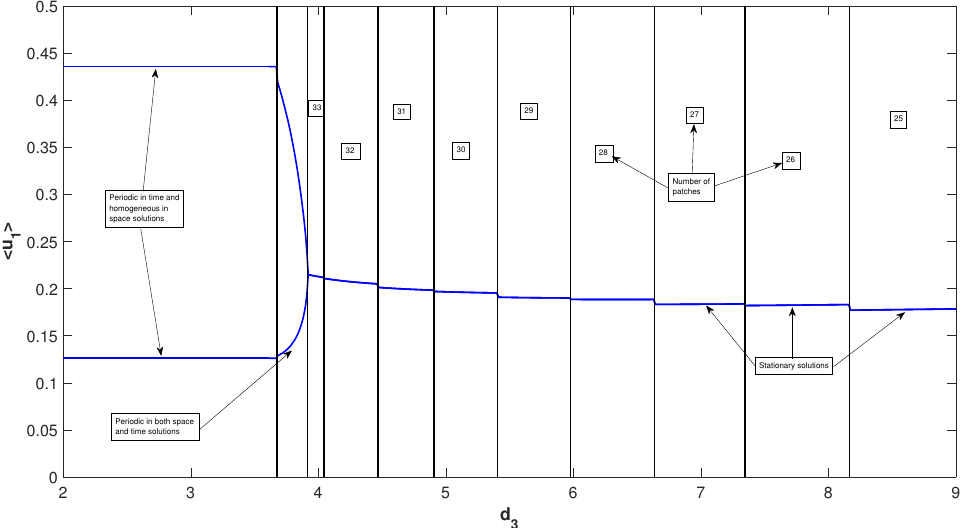
Figure 7. Single parameter bifurcation diagram for the spatially averaged density of first prey population ( < u 1 > ) with respect to the diffusion coefficient d 3 . Here, (cid:101) = 6.0 and other parameter values are mentioned in